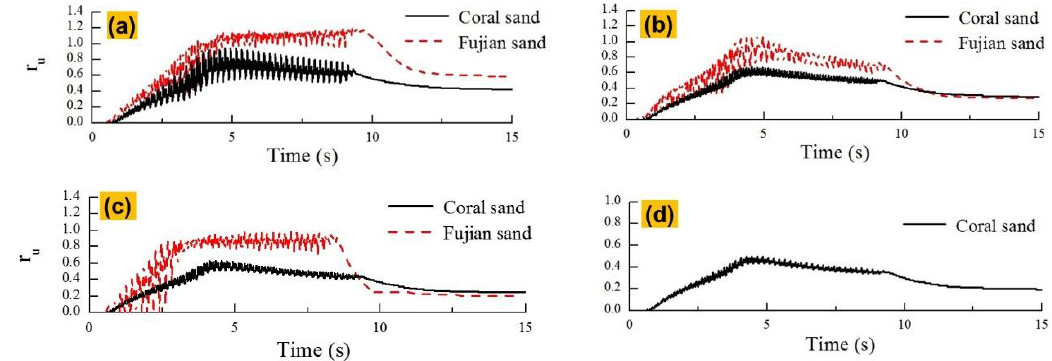
Figure 8. Excess pore pressure ratio time history curves under 0.2 g shaking intensity: ( a ) P1 position; ( b ) P2 position; ( c ) P3 position; and, ( d ) P4 position. Table 4. Comparison of peak excess pore pressure ratios.